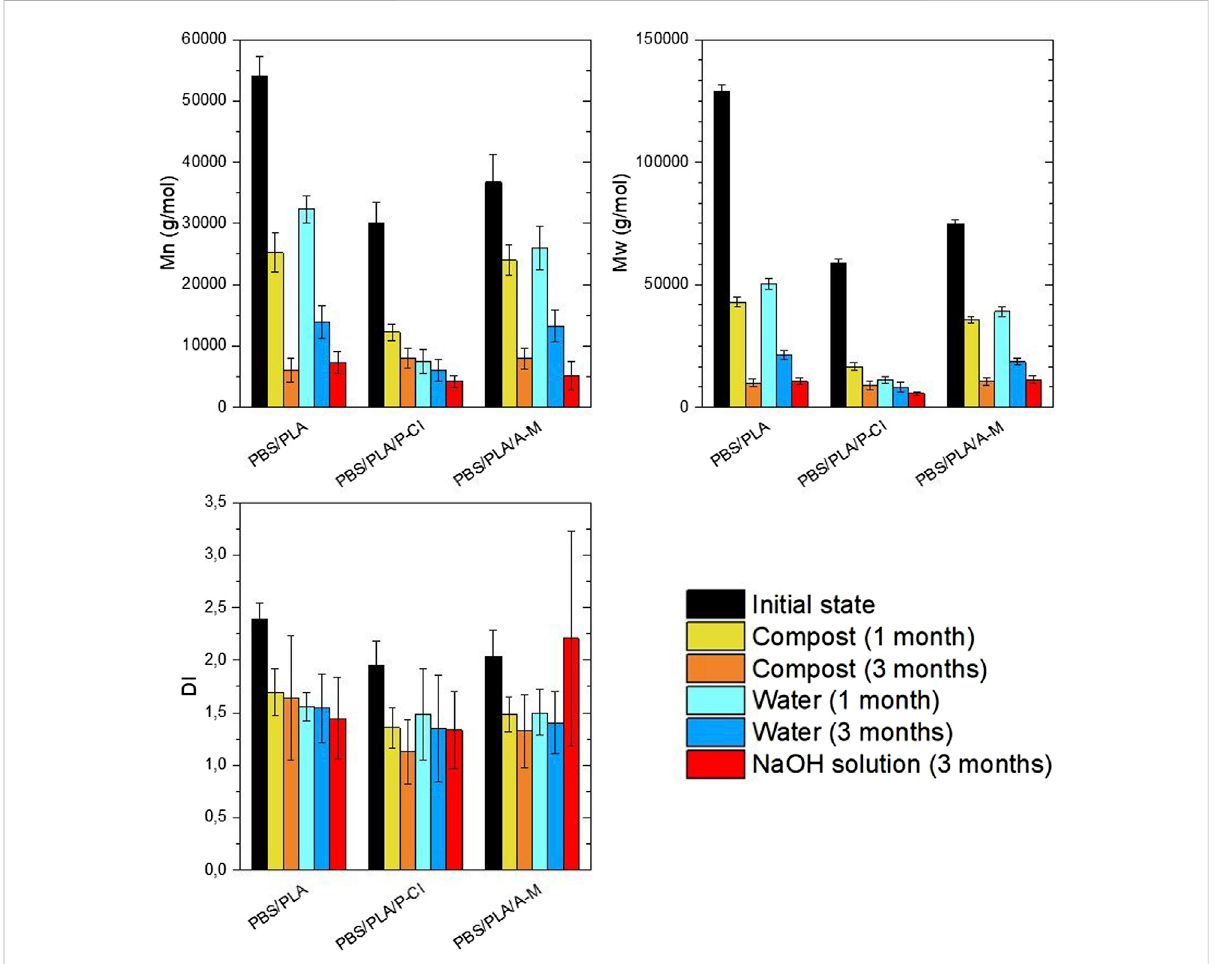
FIGURE 9 Mn , Mw and dispersity index measured with CHCl at 58 °